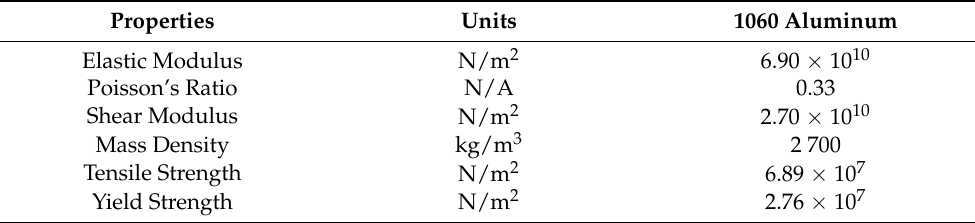
Table 1. Main characteristics of 1060 aluminum alloy. Properties